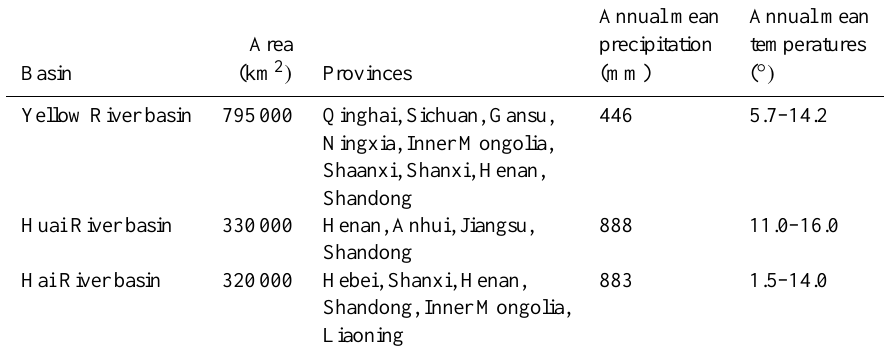
Table 1. General characteristics of the study